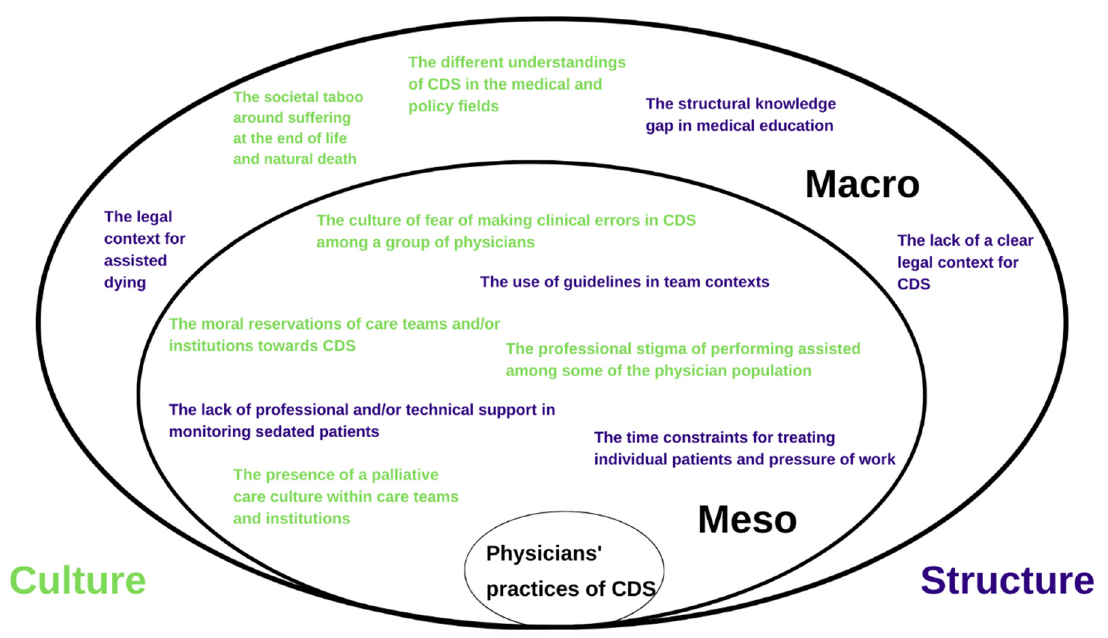
Figure 1. Physicians’ experiences and perceptions of the environmental factors affecting their practices of continuous deep sedation until death (CDS). The specific positions of the environmental factors identified at the meso and macro levels in the figure have no intrinsic meaning in terms of influence, but were chosen to make it clear that all factors are intertwined.